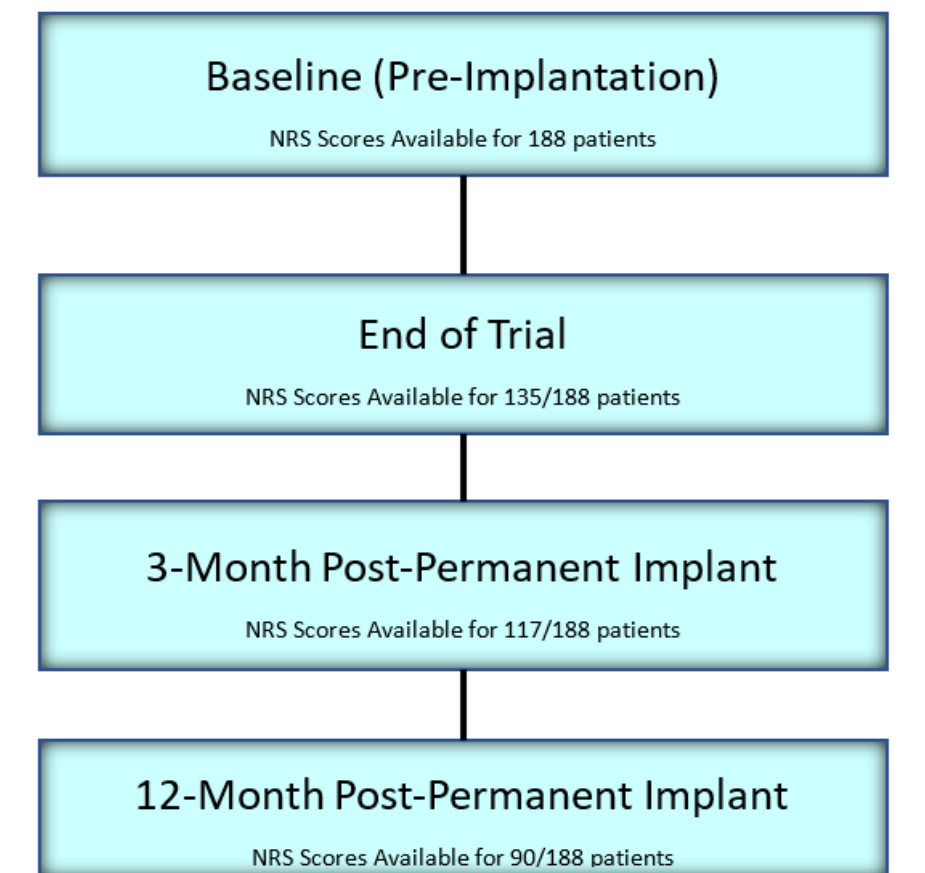
Figure 1. Patient Disposition. Table 1. Baseline and demographic characteristics in analyzed patients ( n = 188).